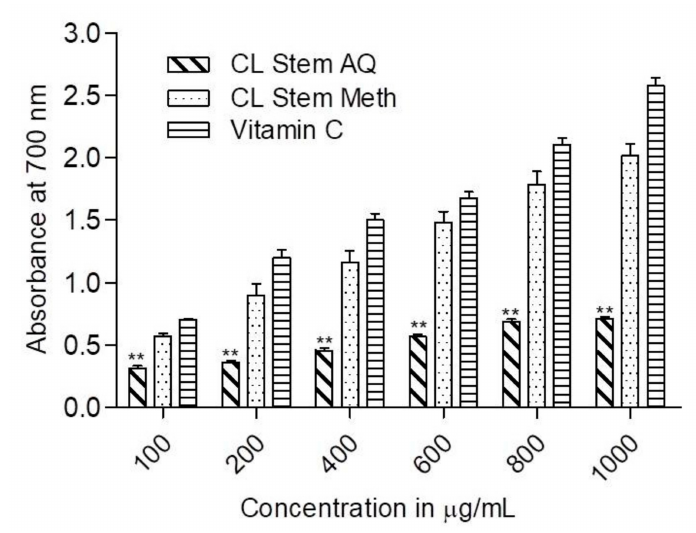
Figure 3. Reducing power of C. lanceolatus stem methanolic (Meth) and aqueous (AQ) extracts. The reducing power was measured at di ff erent extract concentrations (200–1000 µ g. Vitamin C was used for comparison. The results are expressed as a mean ± SD of three replicates. ** p < 0.01 compared to vitamin C.